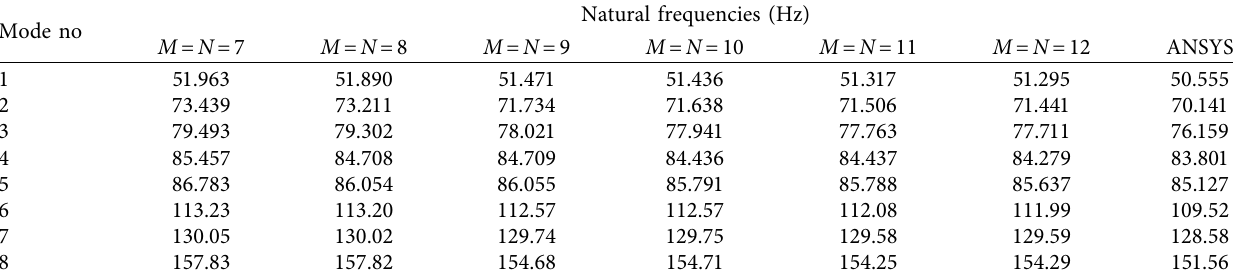
Table 2: First eight natural frequencies of the stiffened double panel-cavity coupled system.